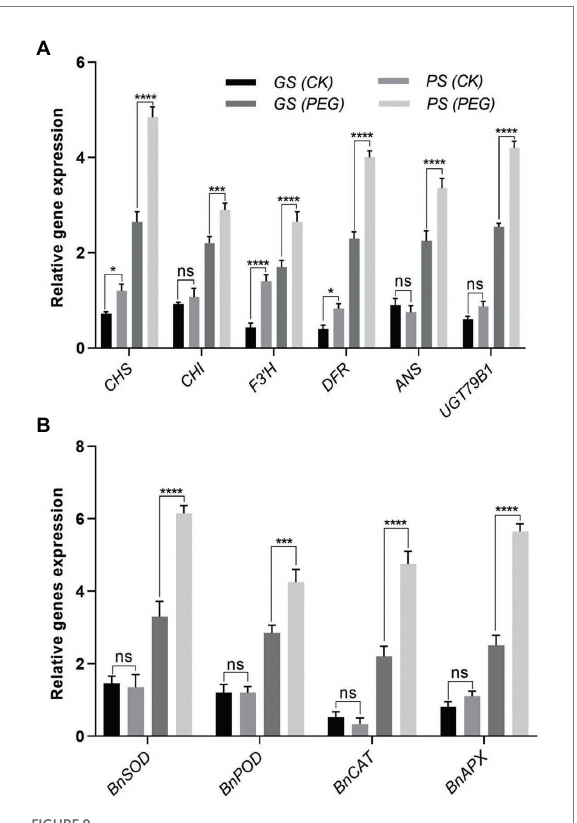
FIGURE 9 Purple and green stem Brassica napus plants under drought (10% PEG-6000). (A) Relative expression of anthocyanin biosynthesis genes including CHS , CHI , F3’H , DFR , ANS , and UGT79B1 . (B) Relative expression of antioxidants enzymes related genes such as BnSOD , BnPOD , BnCAT , and BnAPX , respectively. Different symbols represents significance level as * p = 0.05, ** p = 0.01, *** p = 0.001, **** p = 0.0001. ns,